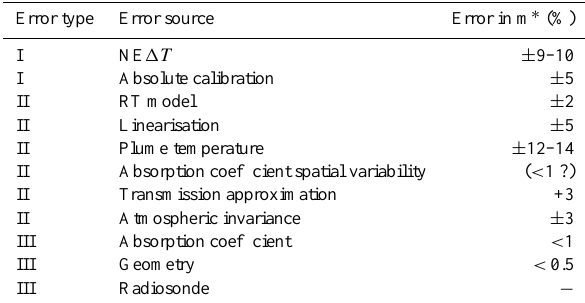
Table 4. Summary of error types and estimated error